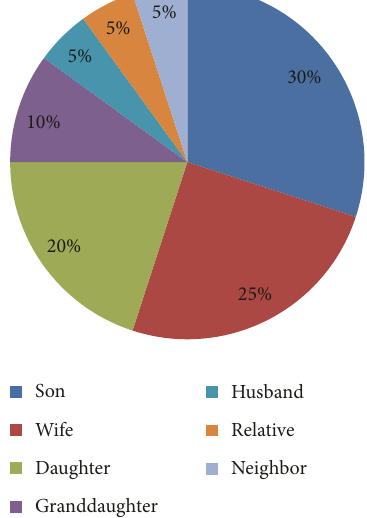
Figure 1: Caregivers’ relationship with the PD patients.